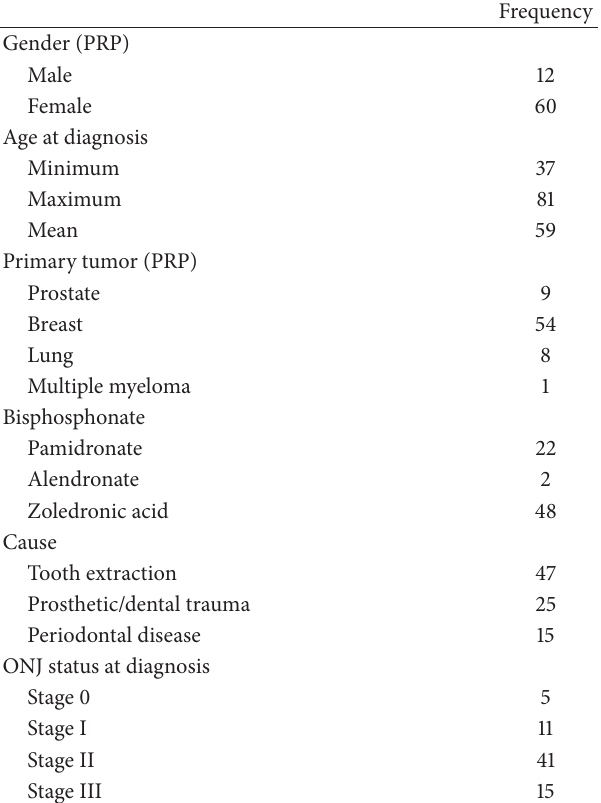
Table 1: Patients